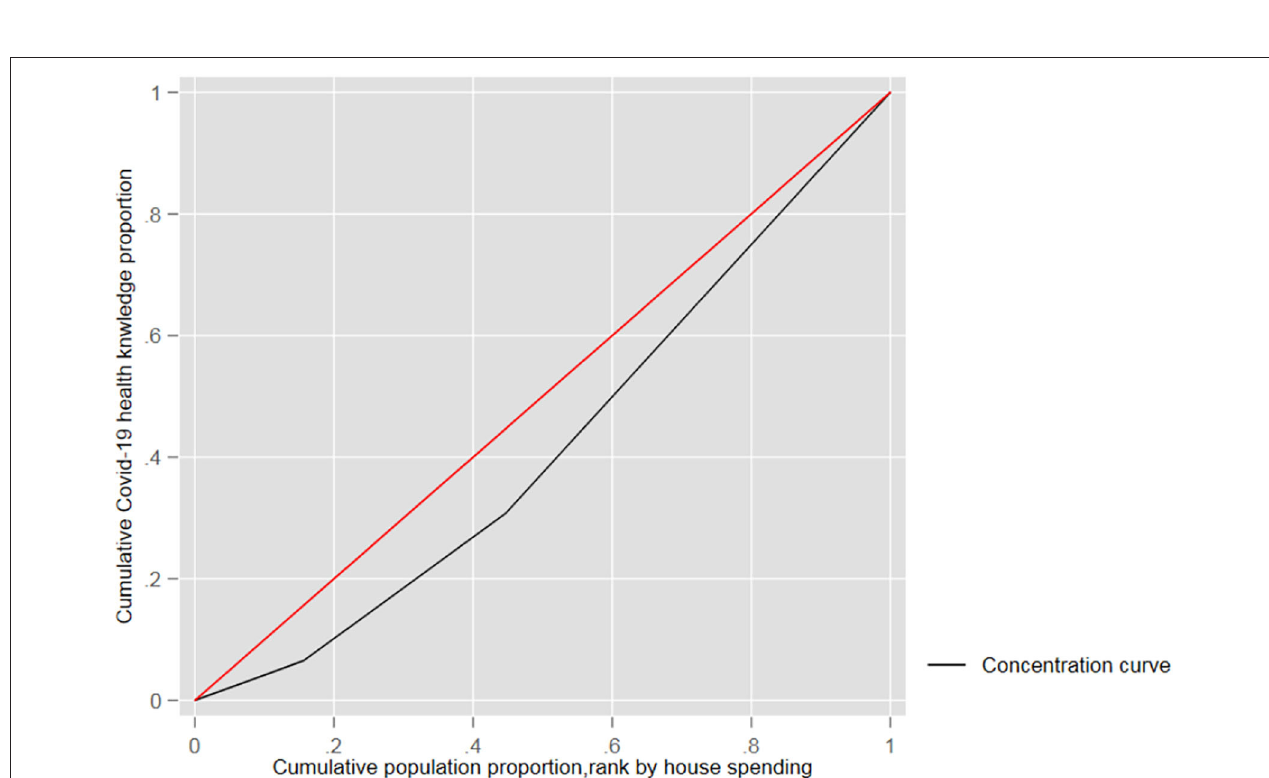
FIGURE 3 | Consumption-related inequality in health